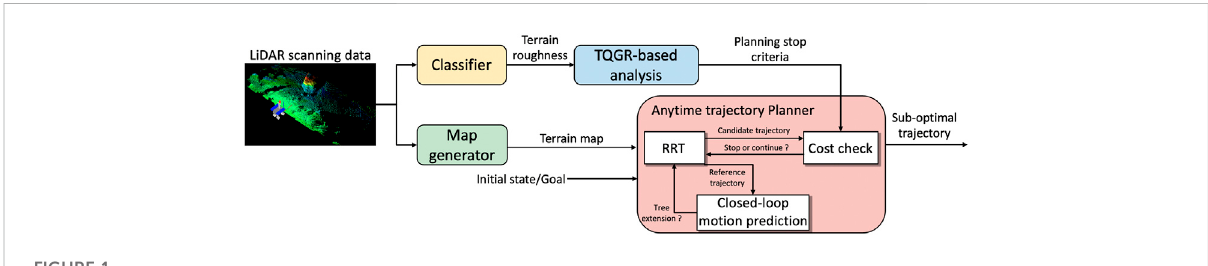
FIGURE 1 Proposed trajectory planning framework.